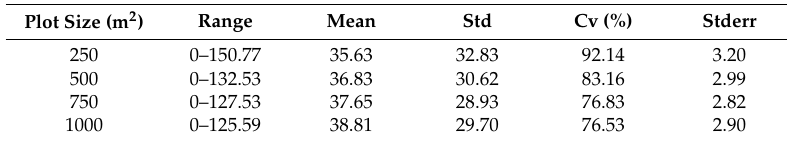
Table 1. Statistical summary of aboveground biomass (Mg ha − 1 ) for the 105 sample plots based on different sample plot sizes.